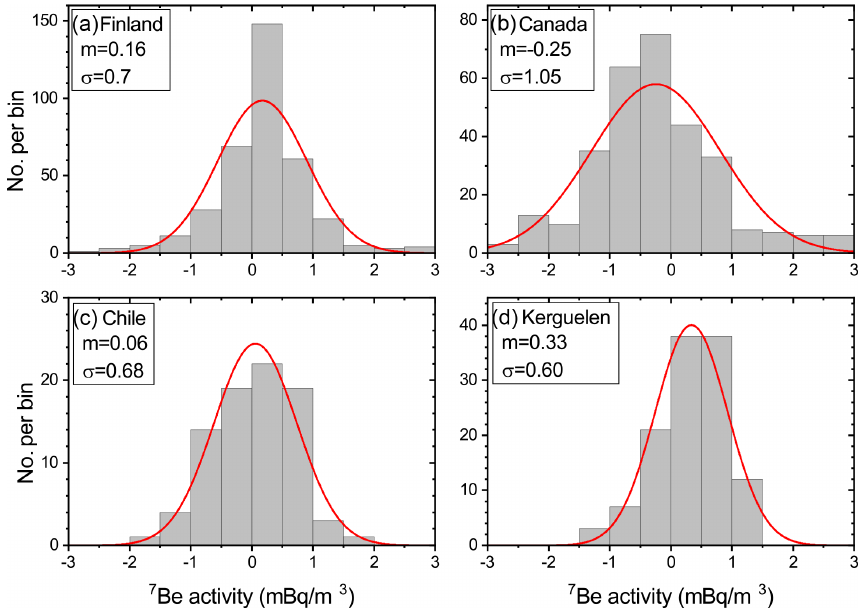
Figure 11. Histograms of the difference between modeled and measured 7 Be weekly concentrations (blue and red curves in Fig. 1, respec- tively) for the four locations analyzed here (see Table 1). Red curves depict the best-fit Gaussians whose parameters (the mean m and standard deviation σ ) are quantified in the